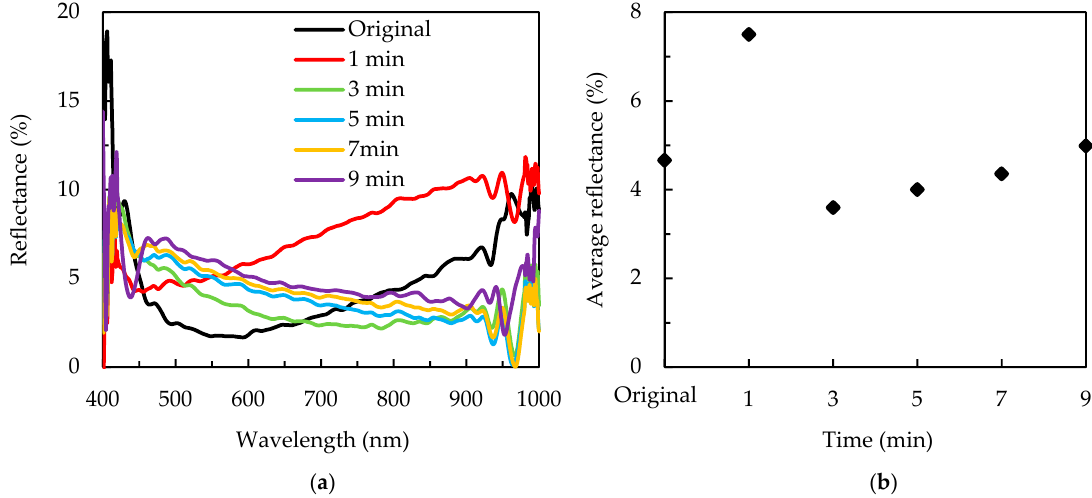
Figure 7. ( a ) Reflectance spectra, and ( b ) average reflectance for the SiN x /Al 2 O 3 passivated silicon wafers with a different MACE time.